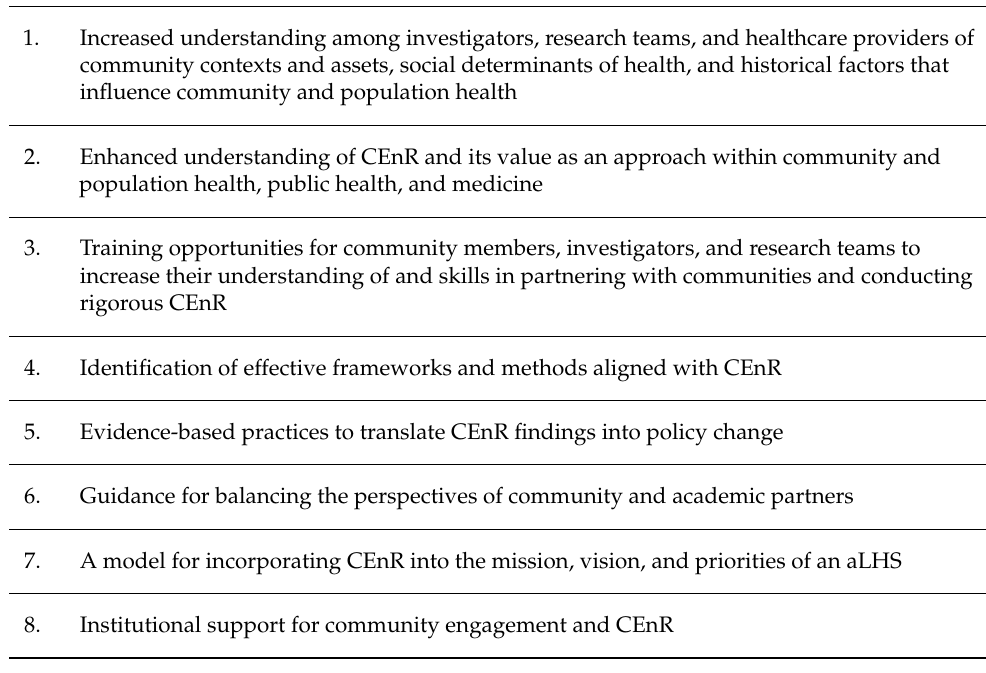
Table 4. Emergent needs to support and enhance community-engaged research (CEnR) within an academic learning health system